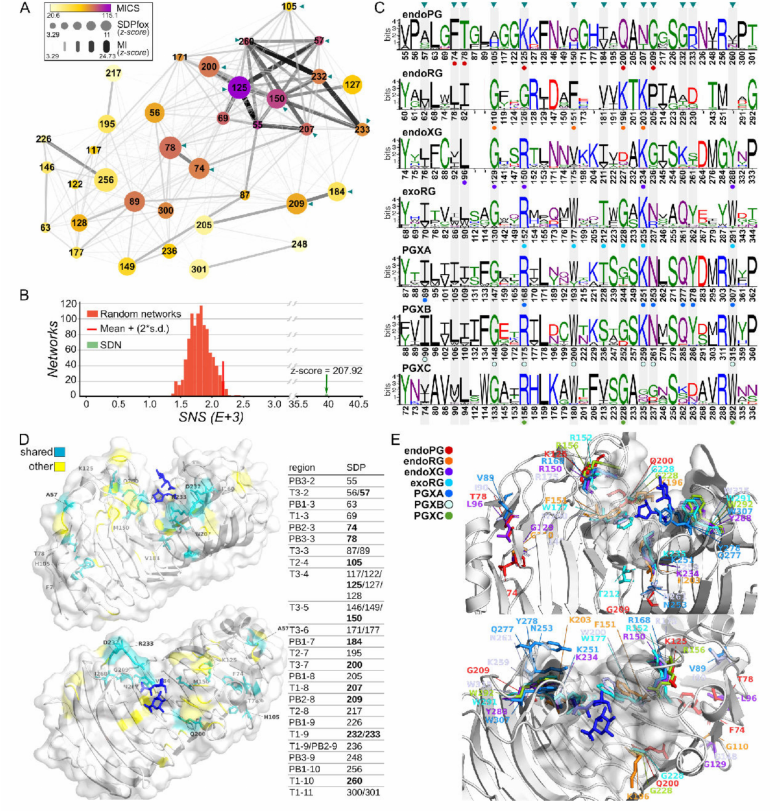
Figure 6. SDP identification and mapping in ascomycete GH28. ( A ) The SDN of the seven-cluster comparison (endoPG vs. endoRG vs. endoXG vs. exoRG vs. PGXA vs. PGXB vs. PGXC) has 36 SDPs represented as nodes with diameter according to SDPfox z-score and color according to its MICS. Edges represent MI z-scores as indicated, numbering according to 1CZF. Triangles indicate shared SDPs, i.e., identified in all four principal analyses (see main text); ( B ) Z-score distribution of 1000 randomly generated networks (incidence histogram) and the SDN (indicated by green arrow). The red vertical line indicates mean + (2*s.d.); ( C ) SDP logos for each class. Numbering according to the subfamily’s reference sequence (described in the main text). Triangles indicate shared SDPs; ( D ) 1CZF in two rotational views with the shared SDPs in light blue sticks, other SDPs are in yellow. Blue sticks, galacturonates (1KCD). The location of the SDPs in the corresponding pleated sheets or turns is indicated in the table, numbering according to 1CZF (bold, shared SDPs); ( E ) 1CZF (cartoon) and other reference structures aligned to 1KCD in two rotational views (galacturonates in blue sticks) with SDPs (sticks) that are highly conserved within their subfamily. Residues are colored and numbered according to the subfamily and its reference sequence, as indicated. Highlighted residues are indicated in ( C ) with correspondingly colored